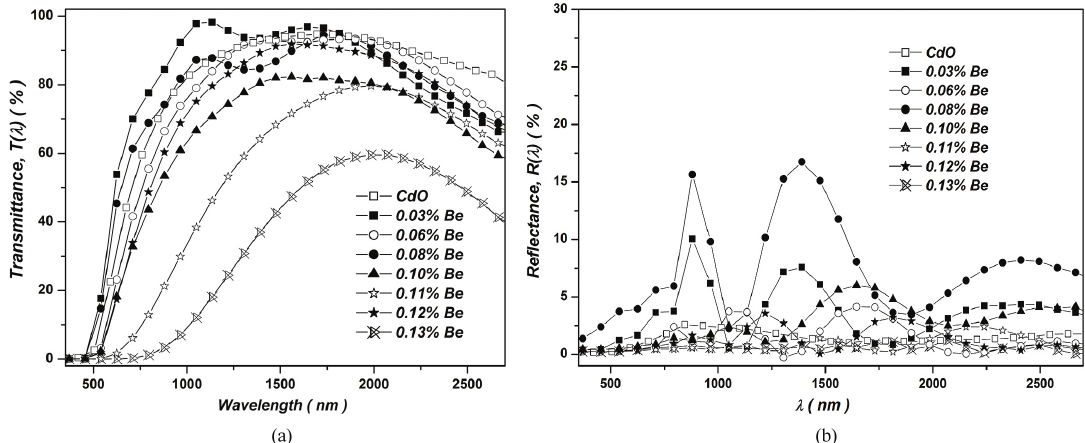
Figure 5. Spectral normal transmittance (T(λ)) and reflectance (R(λ)) of the pure and Be-doped CdO films grown on glass